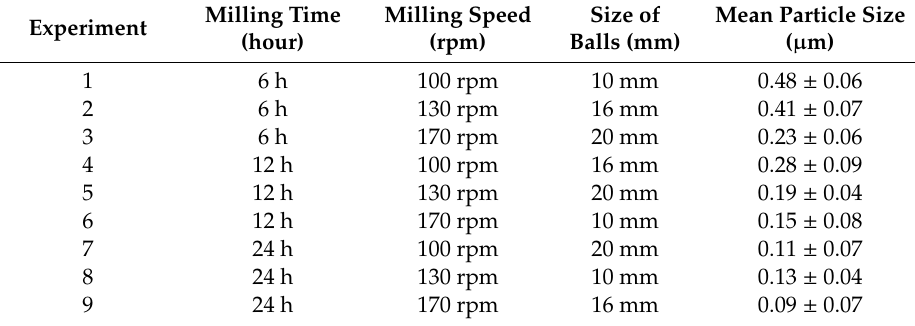
Table 2. Experimental results for the particle size (mean ± SD, replicated three